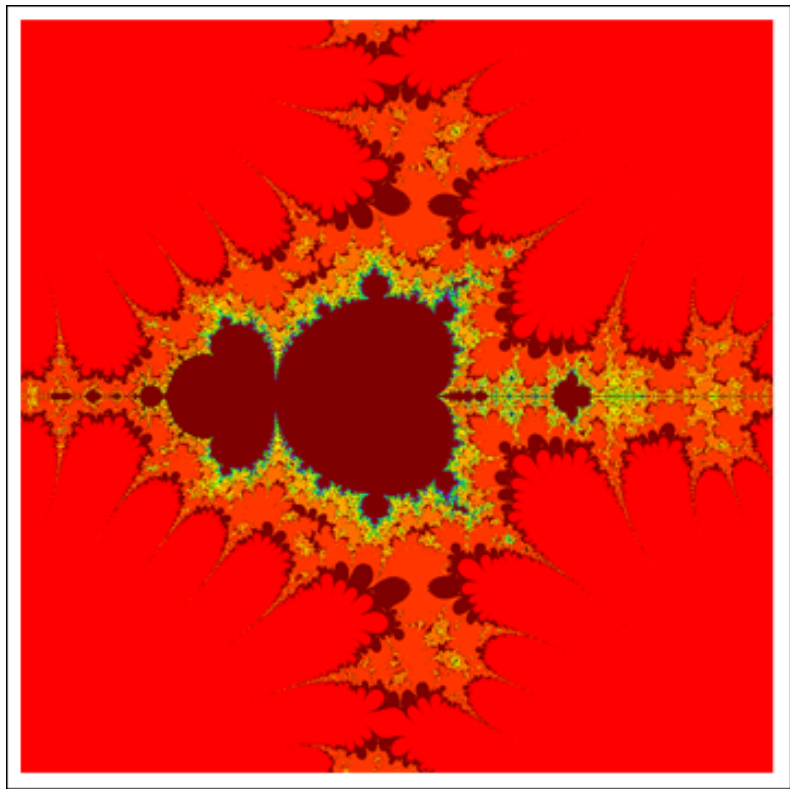
Figure 22. M-set for τ ( z ) = sin ( z 2 ) + c via DKIS. The image execution time is 183.423 s.